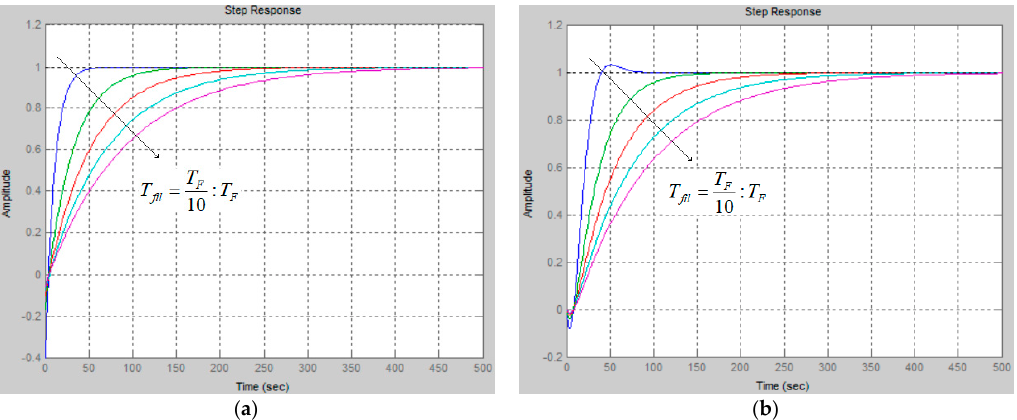
Figure 6. The indicial responses with IMC: ( a ) Proportional–Integral-Derivative (PID); ( b ) pressure indicator (PI).